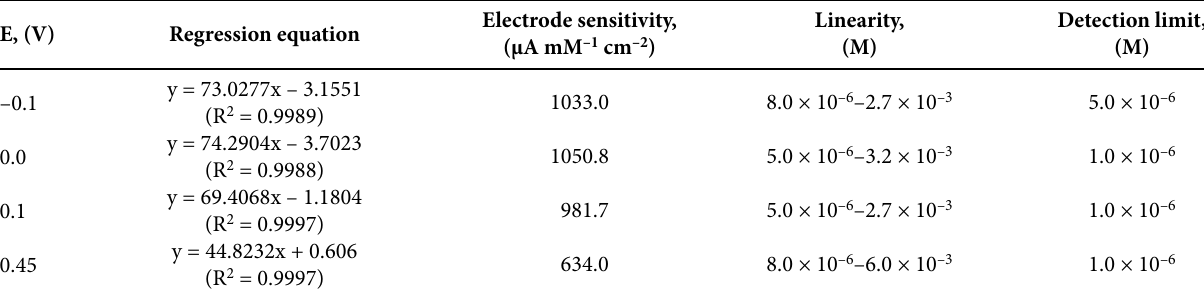
Table 2. Analytical parameters of RuOHCF/GC for iodate detection in PBS (pH 1.0); temperature 25 o C. Electrode sensitivity, E, (V) Regression equation